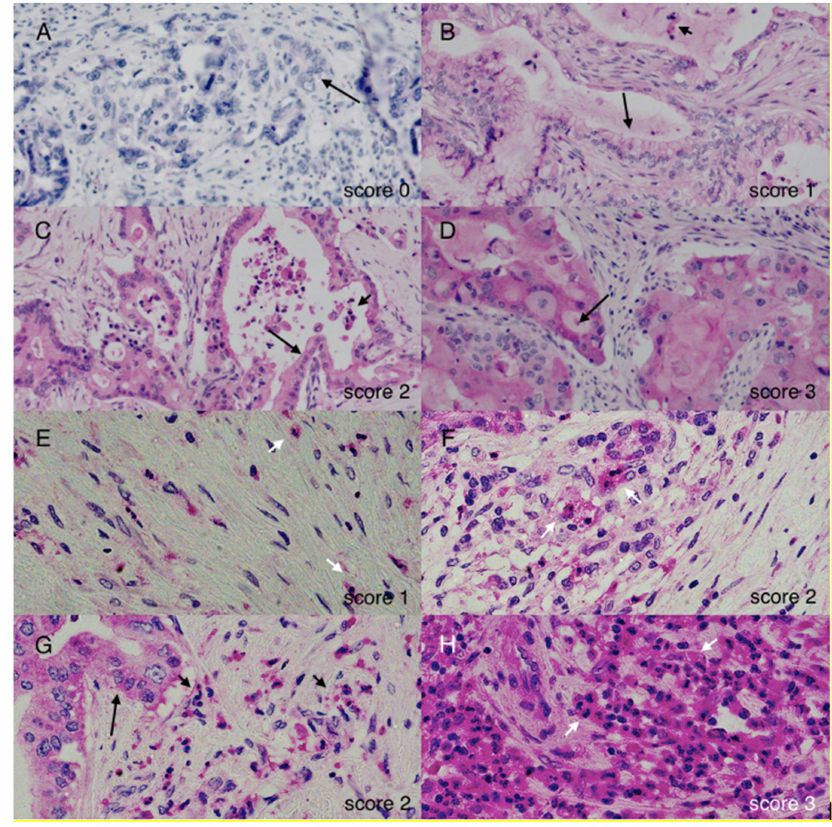
Figure 1. Staining patterns. Negative matrix metalloproteinase 8 (MMP-8) immunostaining in ( A ) scored as 0. Positive MMP-8 immunostaining in ( B – D ) scored as 1–3, respectively. MMP-8- positive polymorphonuclear cells (PMNs) in the tumour area scored as 1 in ( E ), 2 in ( F ) and ( G ) and 3 in ( H ). Long arrows indicate the location of cancer cells, while short arrows indicate